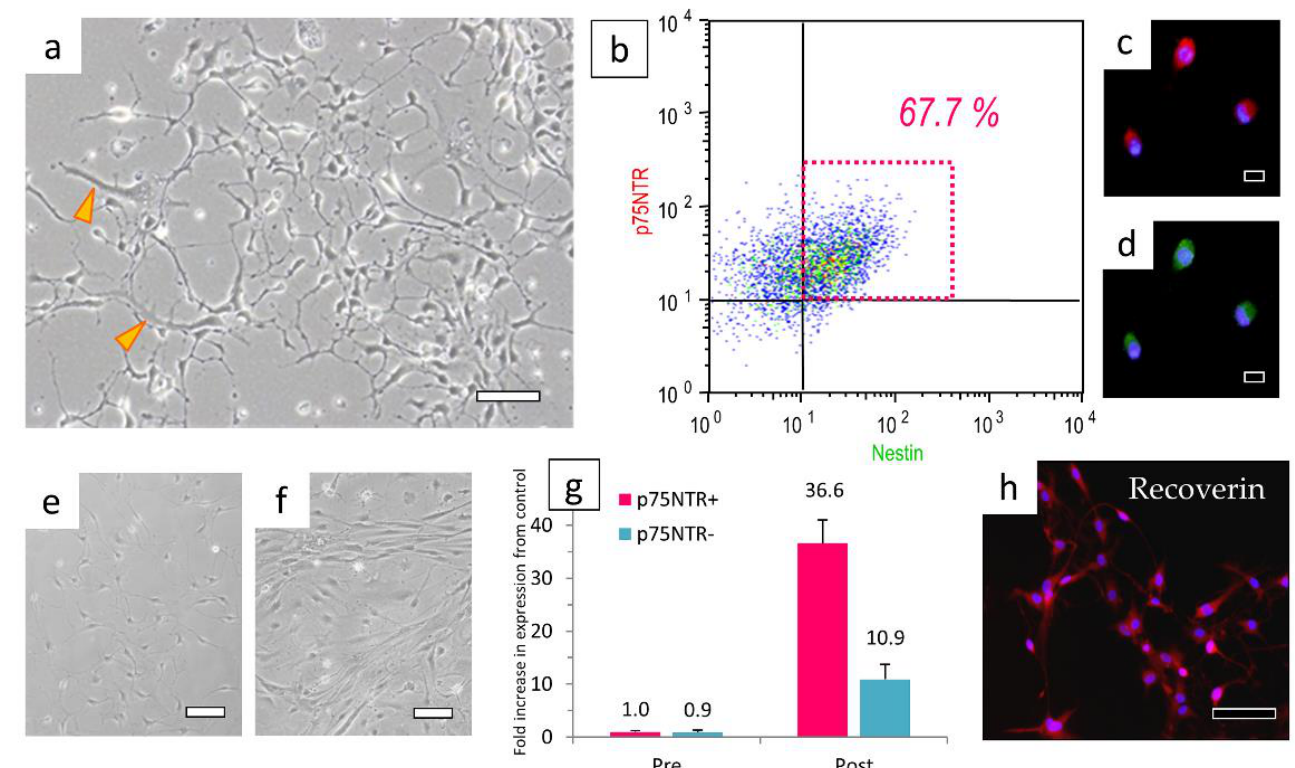
Figure 7. Cells sorted with p75NTR can concentrate Recoverin-positive cells. ( a ) Before p75NTR sorting, cells with large cytoplasms ( arrowheads ) were mixed. ( b ) Fixed cells were analyzed for p75NTR and Nestin by FCM. Most of the cells sorted in the strong positive region of p75NTR were double-positive for ( c ) p75NTR and ( d ) Nestin. ( e , f ) The morphology of cells sorted by their strong positivity for ( e ) p75NTR or ( f ) their weak positivity or negativity for p75NTR. ( g ) Relative semi-quantitative analysis of Recoverin gene expression in cells selected by p75NTR, and pre/post-differentiated cells. ( h ) Fluorescent immunostaining of Recoverin in differentiated cells. Bar in panel ( a ): 50 μm, bars in panels ( c , d ): 20 μm, bars in panels ( e , f , h ): 100 μm.